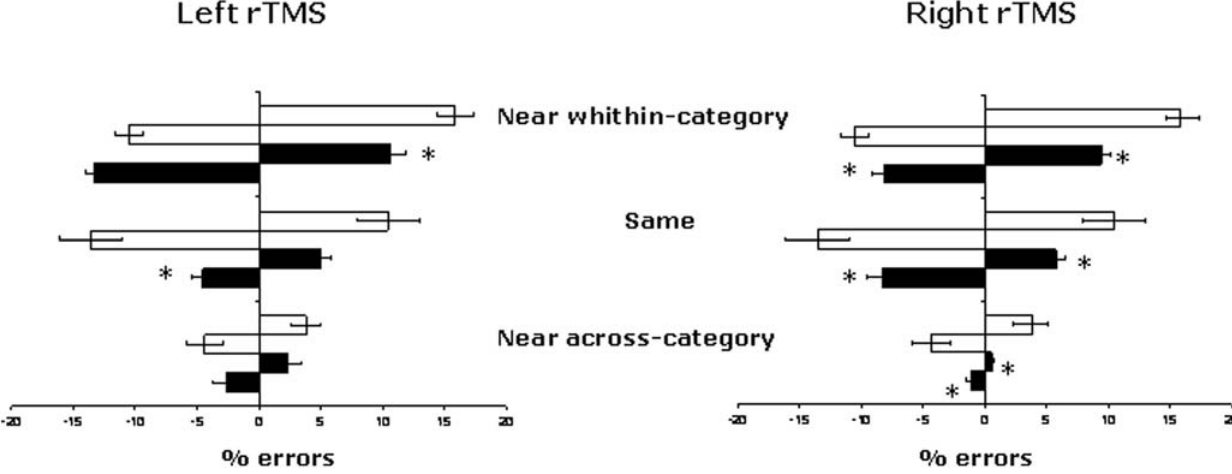
Figure 5. Experiment 5: Mean leftward and rightward errors ( 6 1 SE) in the Semantic distance judgment task in the different experimental conditions. Negative values (black bars) indicate leftward shifts and positive values (white bars) rightward shifts in the judgment. White bars indicate leftward and rightward errors in baseline. Black bars indicate leftward and rightward errors in left rTMS (left panel) and right rTMS (right panel) sessions. rTMS=repetitive transcranial magnetic stimulation.